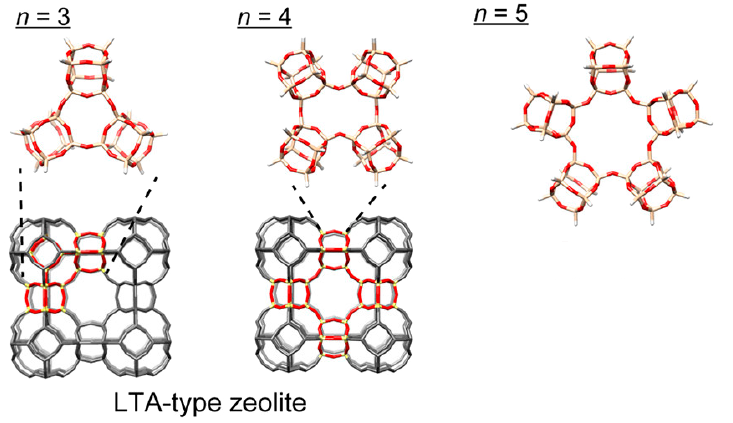
Figure 7. Macrocyclic compounds (cyclic-(R 6 Si 8 O 13 ) n ) obtained by intermolecular condensation of di-silanol functionalized D4R siloxanes. The R groups are omitted for clarity. Reprinted with permission from Inorg. Chem. 2018 , 57 , 14686 − 14691 [60]. Copyright 2018 American Chemical Society.